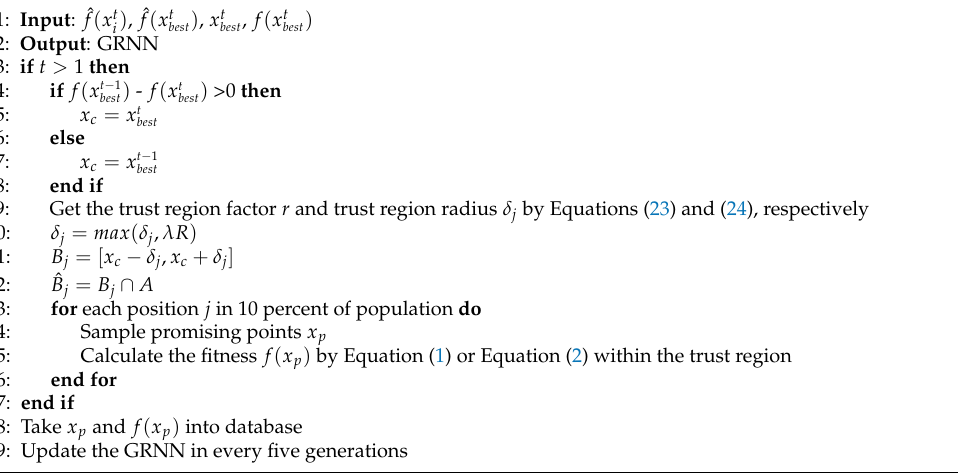
Algorithm 1 Pseudo-code of updating GRNN by